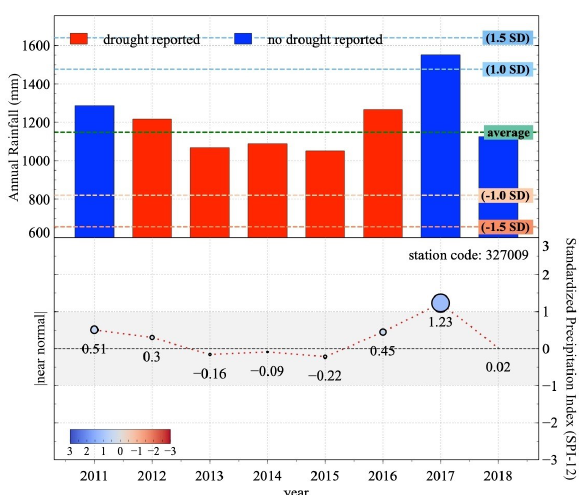
Fig. 9. Interpretation of SPI12 as drought indicator with the amount of annual rainfall and drought information at station Samoeng (327009).